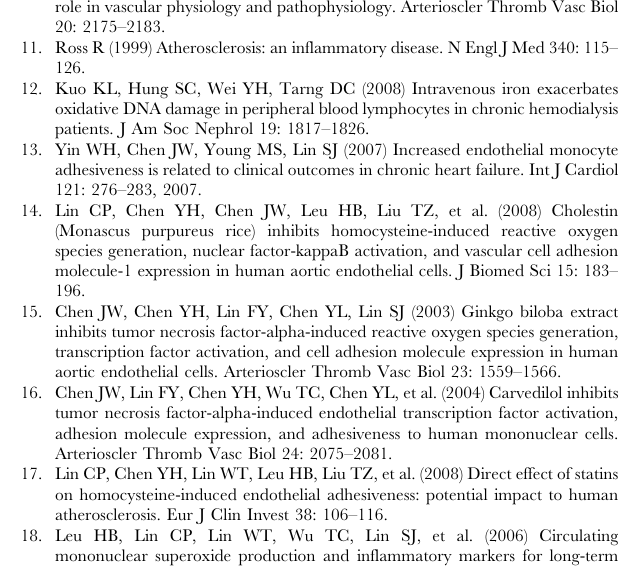
Figure S1 Cell viability of human aortic endothelial cells 4 h following culture with various concentrations of ferric chloride hexahydrate (Atofen), as determined by the MTT assay. The percentage of cell viability in the Atofen- treated groups was compared with the untreated group (cell viability = 100%). The data are expressed as the mean 6 SEM from three independent